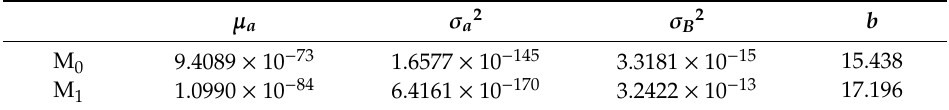
Table 5. Distribution parameters of storage lifetime at 20 ◦ C for